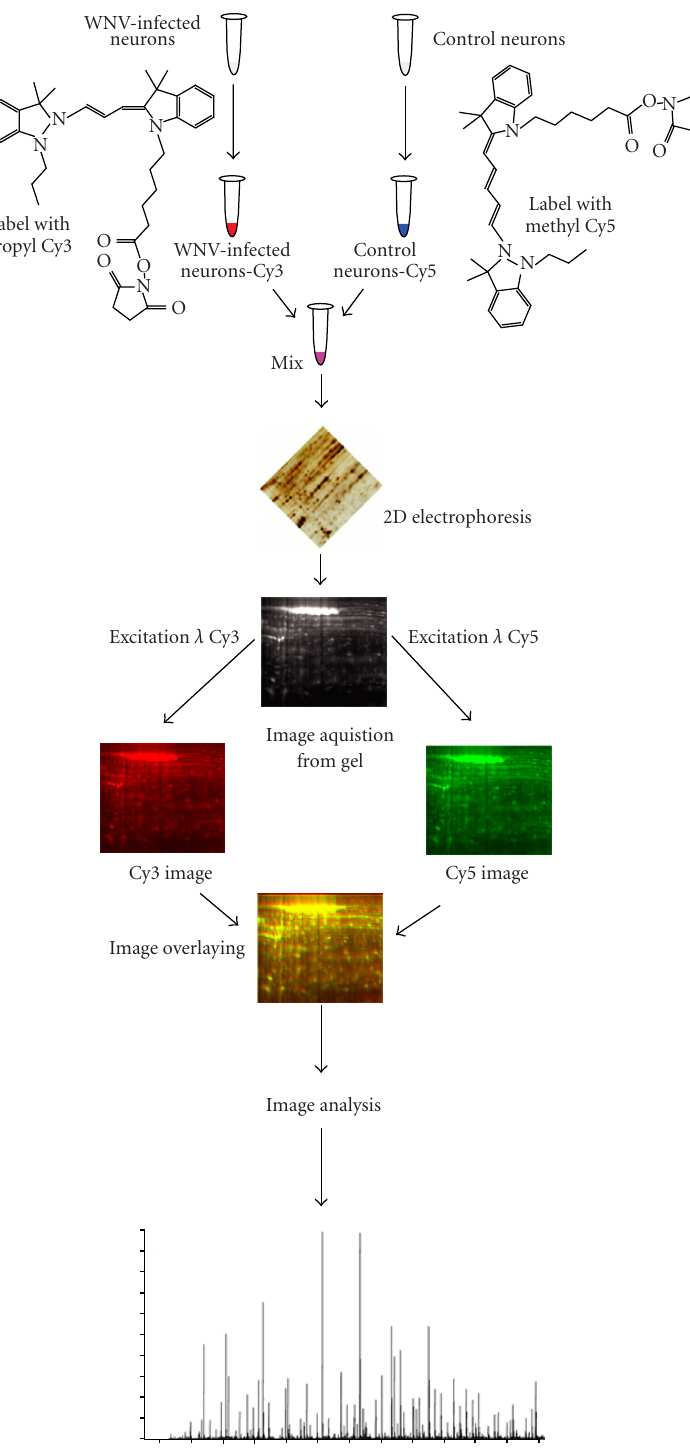
Figure 1. Flow chart of 2D-DIGE analysis. Proteins from WNV-infected neurons and respective controls are labeled with Cy3 and Cy5 dyes. These labeled samples are then mixed and applied to a 2D gel. The resulting protein pattern is compared and analyzed for di ff erential protein expression. Proteins can be identified by mass spectrometry. (Modified from Van den Berg and Arckens, 2003.) Proteins are first pre-electrophoretically labeled with one range of protein detection. Molecular weight and charged of the three spectrally resolvable fluorescent cyanine dyes matched cyanine dyes enable multiplex labeling with dif- (Figure 1). This improves the sensitivity and dynamic ferent samples run on the same gel